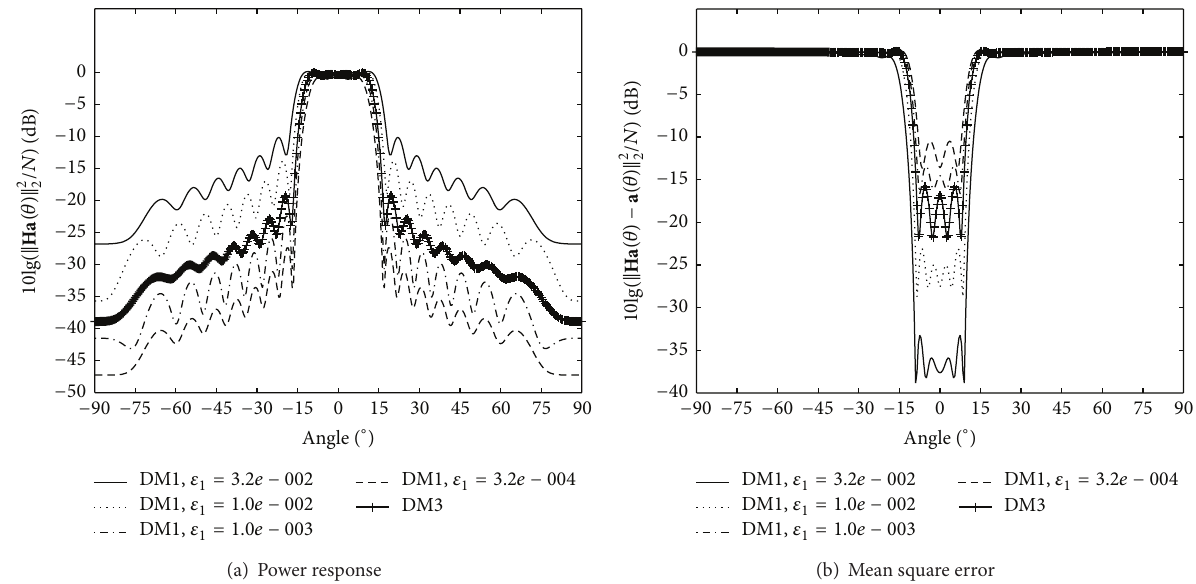
Figure 1: Characteristics of the spatial matrix filters designed by DM1 and DM3.